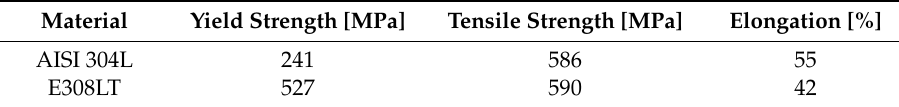
Table 2. Mechanical properties of AISI 304L and E308LT.